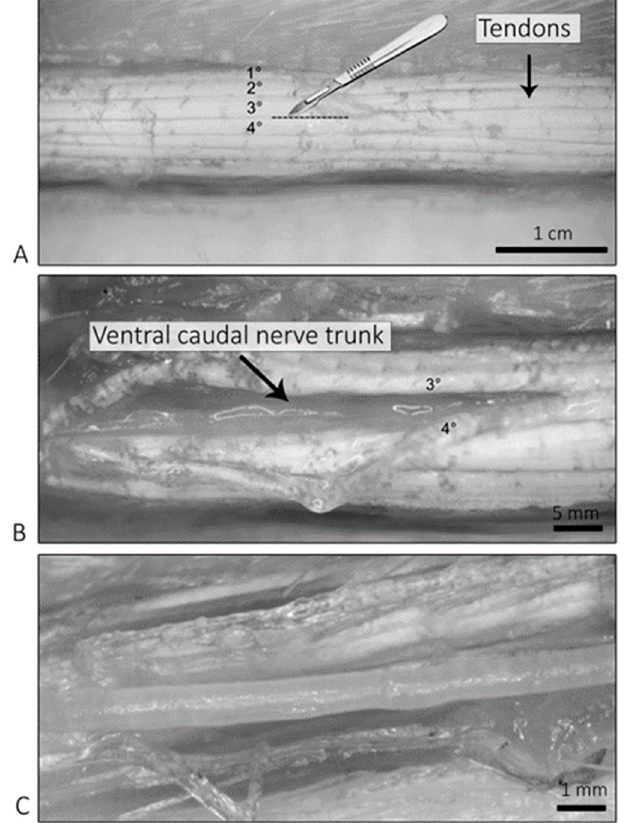
Figure 8. Harvesting procedure. In ( A ) tendon, localization is shown. In ( B ) the exposed ventral caudal nerve, after displacing the third and the fourth tendon, is shown. In ( C ), a close-up of the isolated nerve is shown.